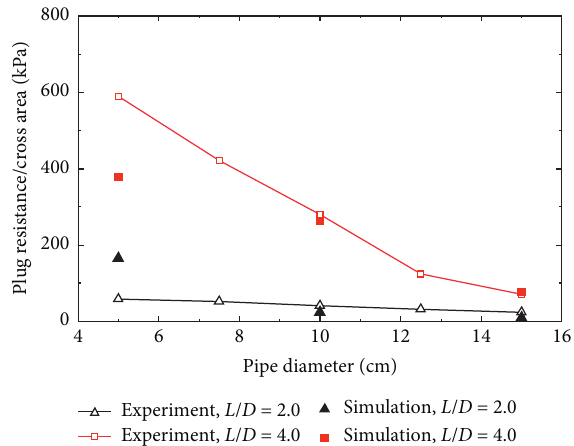
Figure 8: Comparison between experiments and simulations on soil plug resistance over different pile